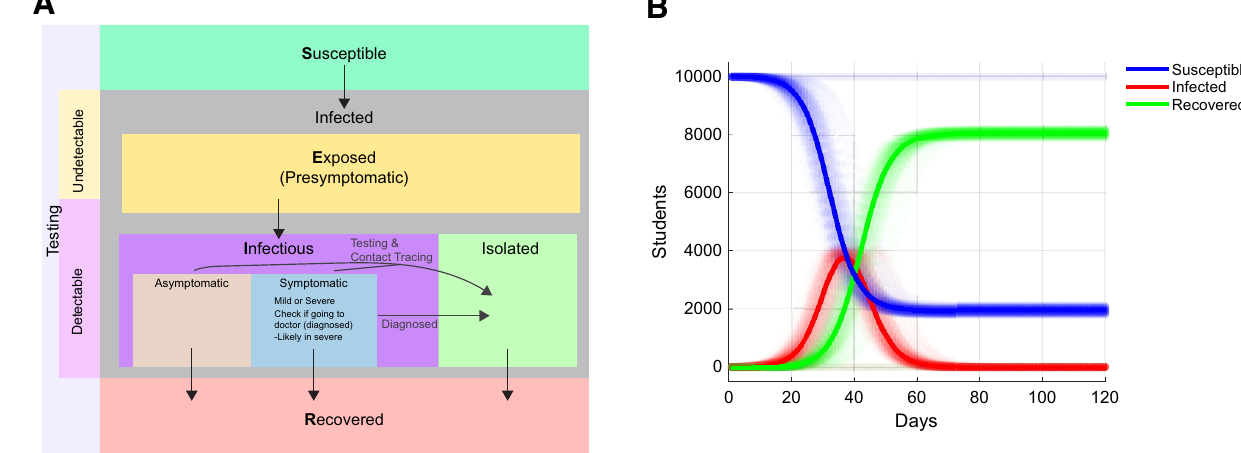
Figure 2. A stochastic agent-based model of COVID-19 transmission. This is a stochastic SEIR model implemented in MATLAB. Each transition in state is based on if–then statements with specific probabilities described in Fig. 3. ( A ) Individuals start as susceptible, and the initial population is seeded with 10 random infected individuals, each starting at a random point of progression through the disease, and with random symptoms. Upon being infected, an individual become exposed (presymptomatic), and is assigned a day for symptom onset. Detectability for testing and infectiousness both begin at 2 days prior to onset of symptoms. Infectious individuals can be either asymptomatic, or symptomatic with mild or severe symptoms. Those with severe symptoms will self-isolate and initiate contact tracing through seeking medical attention. Asymptomatic individuals and those with mild symptoms can be isolated through contact tracing or through detection by a test. Infectious individuals will recover randomly with a median time of 14 days. ( B ) An example of 100 independent simulations with the model. Shown are susceptible, infected (encompassing exposed, infectious, and isolated individuals), and recovered individuals in simulations where no interventions were implemented. Each individual simulation is represented as semi-transparent points, while the median value of all simulations is plotted as a